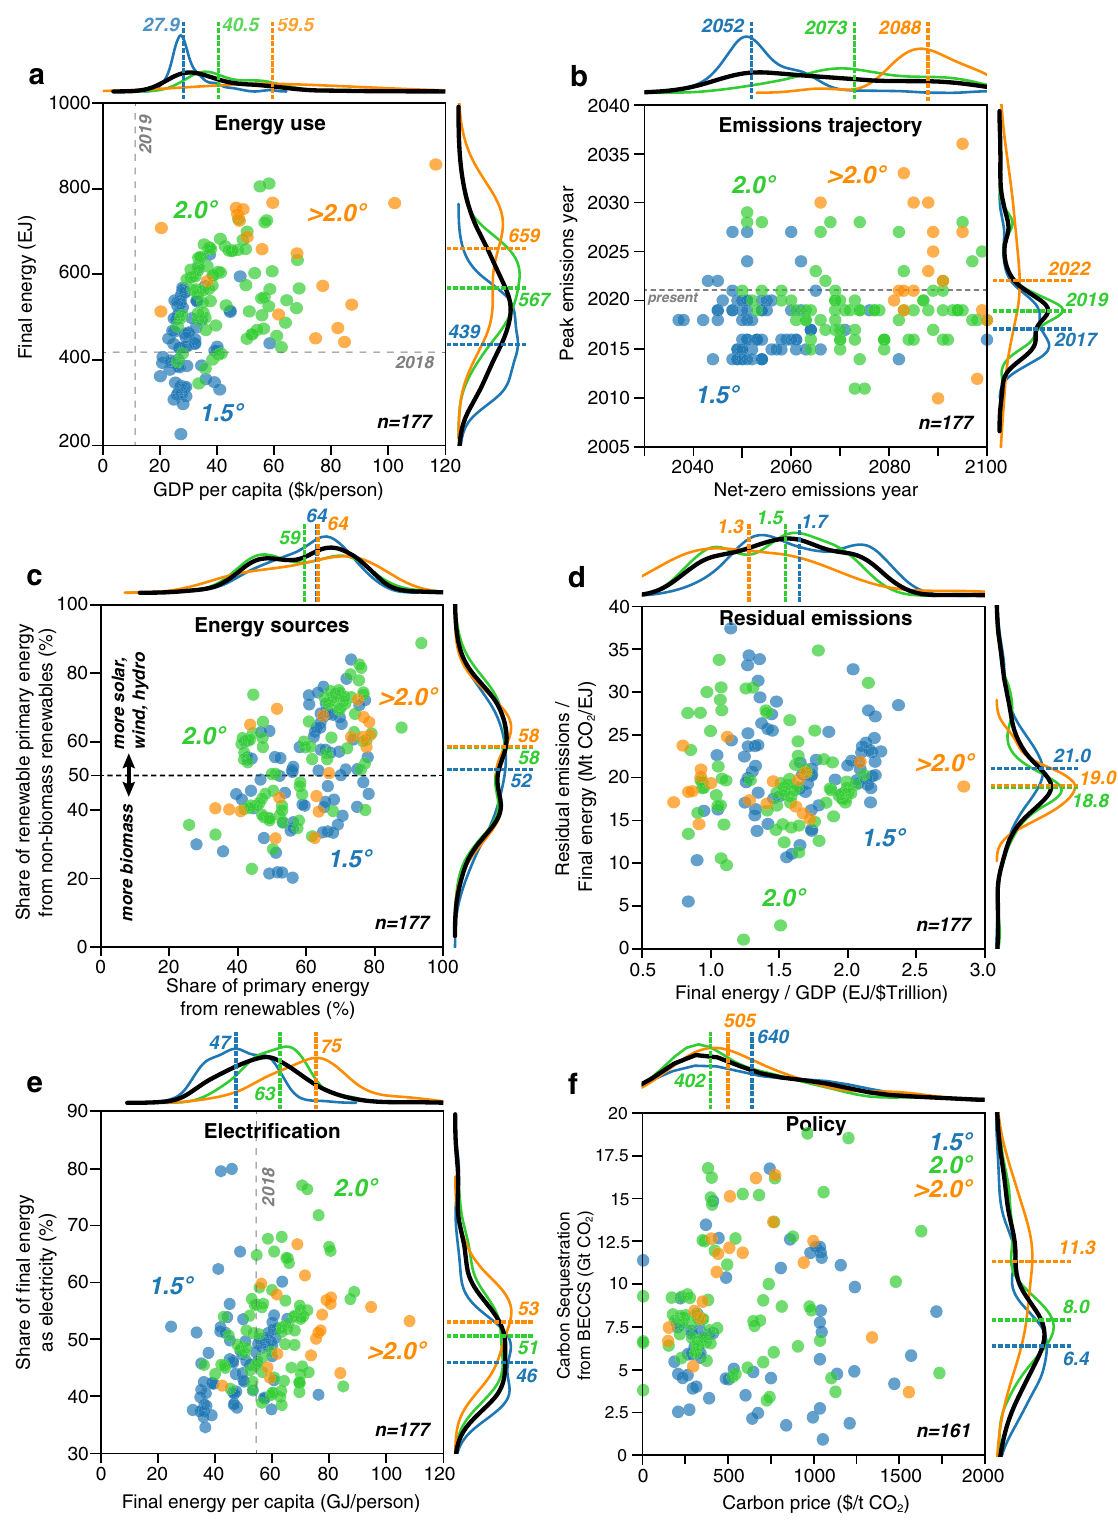
Fig. 1 Energy system parameters in global net-zero CO2 emissions scenarios. Scenarios that reach net-zero emissions show differences in energy use ( a ), emissions trajectory ( b ), energy sources ( c ), residual emissions ( d ), electri fi cation ( e ), and policy ( f ), particularly with respect to warming levels (blue = <1.5 °C, green = <2.0 °C, orange = >2.0 °C). Points represent individual scenarios, with a frequency of scenarios shown along each axis for each warming level (colors corresponding to warming levels) and for all scenarios (black). Colored dashed lines and values indicate medians for warming groups, with colors corresponding to warming groups. Gray dashed lines indicate reference values for the year shown in